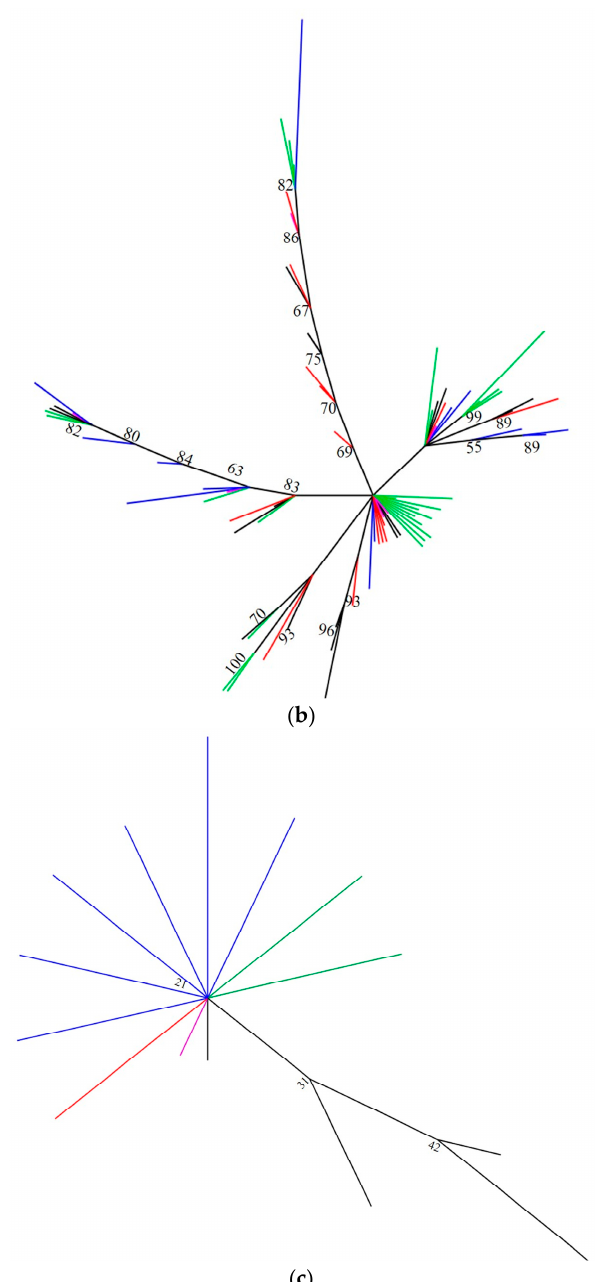
Figure 2. An unrooted Bayesian tree generated from rDNA ITS2 sequence obtained from 2 female and 2 male individuals of ( a ) Scirtothrips dorsalis , ( b ) Thrips palmi and ( c ) Frankliniella occidentalis . Clones from different individuals have been coded in different colors. Bootstrap values are on the branches. Black: Specimen no.1 (SD1, TP1, or FO1), Red: Specimen no. 2 (SD2, TP2, or FO2), Blue: Specimen no. 3 (SD3, TP3, or FO3), Green: Specimen no. 4 (SD4, TP4, or FO4), Pink: Shared haplotype. Number of clones of each specimens included in figures were SD1 = 13, SD2 = 19, SD3 = 18, SD4 = 17 and shared haplotype = 4; TP1 = 17, TP2 = 14, TP3 = 13, TP4 = 26 and shared haplotype = 6; FO1 = 4, FO2 = 1, FO3 = 6, FO4 = 2 and shared haplotype = 1.